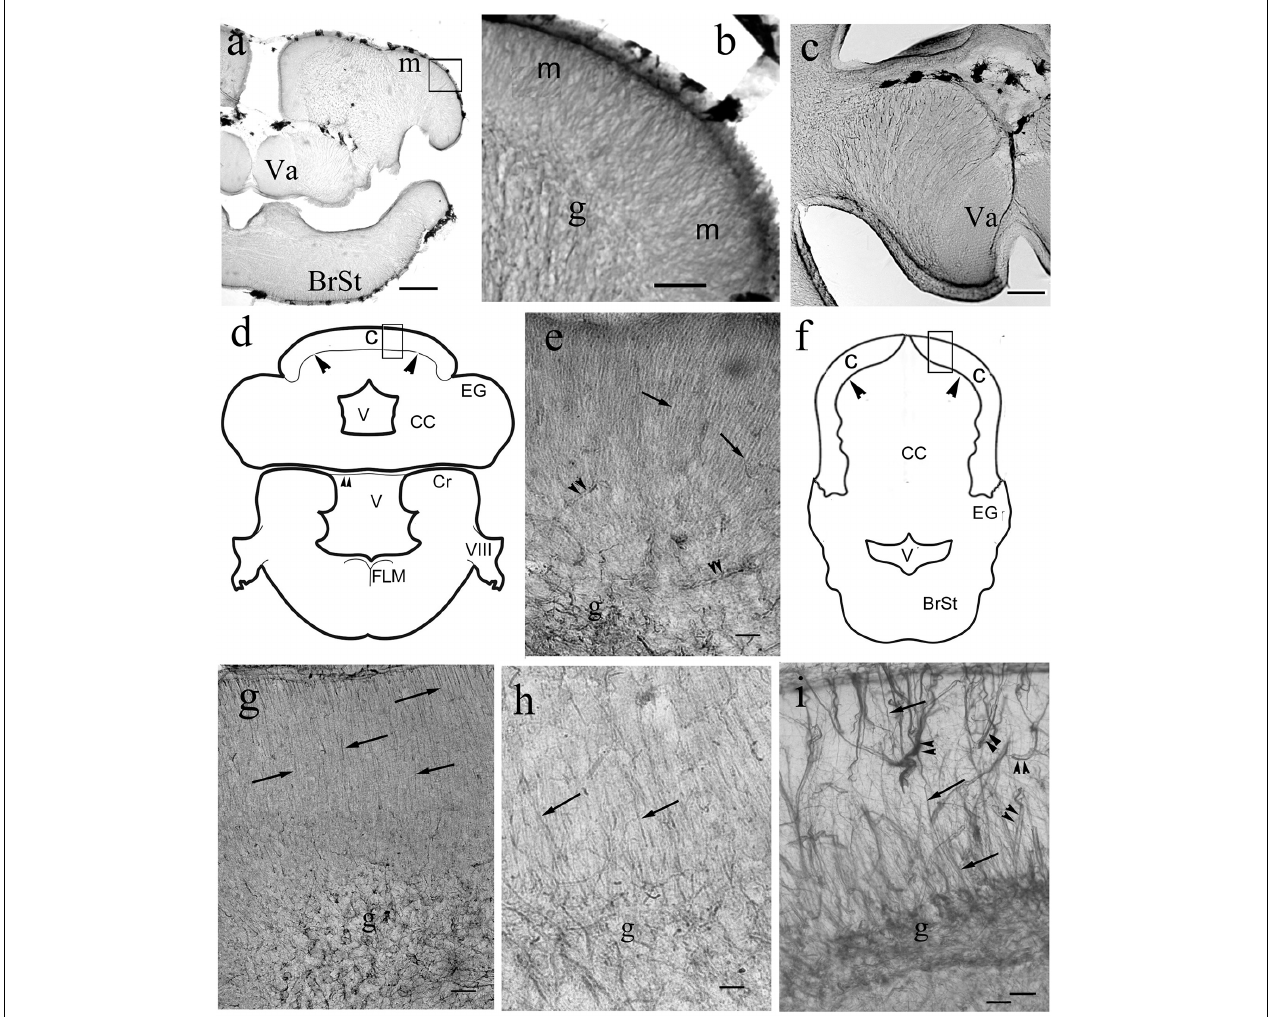
FIGURE 11 | Bergmann-like glia in the cerebella of non-teleosts and basal teleosts. (a) Silhouette of bichir cerebellum with the underlying brain stem (BrSt) for orientation of panels (b,c) . Va: valvula cerebelli, a part of cerebellum crammed into the ventricle. Scale bar: 300 µ m. (b) A detail of bichir cerebellum, for its position see panel (a) ; m: molecular layer with dense process system perpendicular to the surface; g: granular layer. Scale bar: 80 µ m. (c) Astroglial system of the bicirh valvula cerebelli (Va). Scale bar: 100 µ m. (d) Sketch of gar cerebellum with the underlying brain stem redrawn after Parent and Northcutt (1982), with the position of panel (e) . C and arrowheads: cortex, CC: corpus cerebelli, Cr: crista cerebelli, EG: eminentia granularis, FLM: medial longitudinal fascicle, V: ventricle, VIII: 8th cranial nerve. The sketch of the brain stem also helps orientation in the microphotographs of Figure 13 . (e) Detail of gar cerebellar cortex. Arrows: Bergmann-like processes, double arrowheads: vessels, g: granular layer. Scale bar: 80 µ m. (f) Sketch of trout cerebellum for orientation on teleost cerebella, redrawn after Nieuwenhuys and Meek (1997). BrSt: brain stem, C: cortex, CC: corpus cerebelli; EG: eminentia granularis; V: rhombencephalic ventricle; arrowheads: the border of cortex. (g) Knifefish. Arrows: Bergmann-like processes, g: granular layer Scale bar: 100 µ m. (h) Butterfly fish. Marks as in panel (g) . Scale bar: 80 µ m. (i) Eel. Arrows: Bergmann-like processes, double arrowheads: vessels, g: granular layer. Scale bar: 80 µ m.